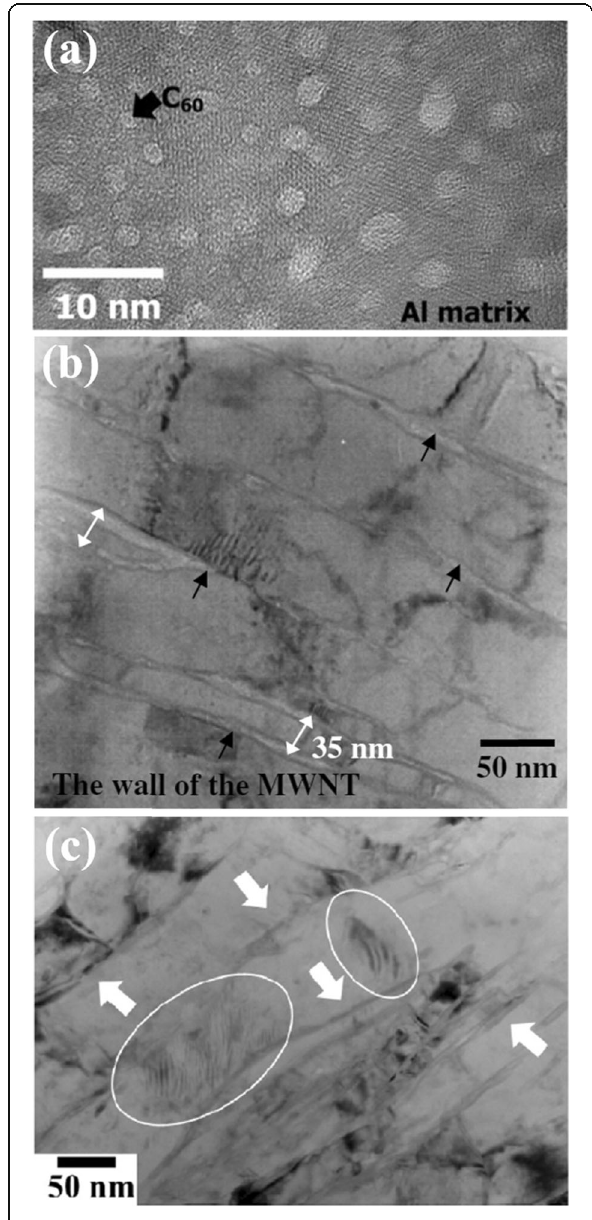
Fig. 6 HR-TEM images of ( a ) Al/fullerenes (Choi et al. 2010), ( b ) Al/CNTs (Choi et al. 2008), and ( c ) Al/graphene composites (Shin et al. 2015a). Reprinted from Choi et al. (2010), Choi et al. (2008), and Shin et al. (2015a) ( Carbon 48, 3700 – 3707, Scr. Mater. 59, 360 – 363, and Carbon 82, 143 –